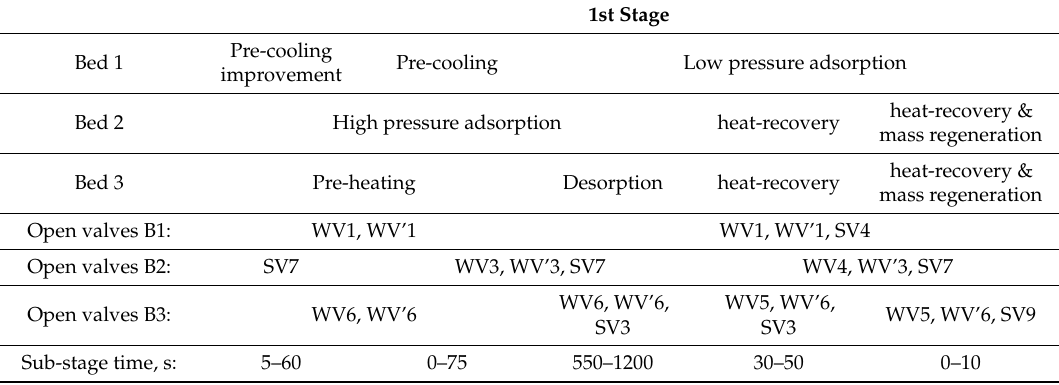
Table 3. New software for the adsorption chiller shown in a single working stage (third time of entire cycle).